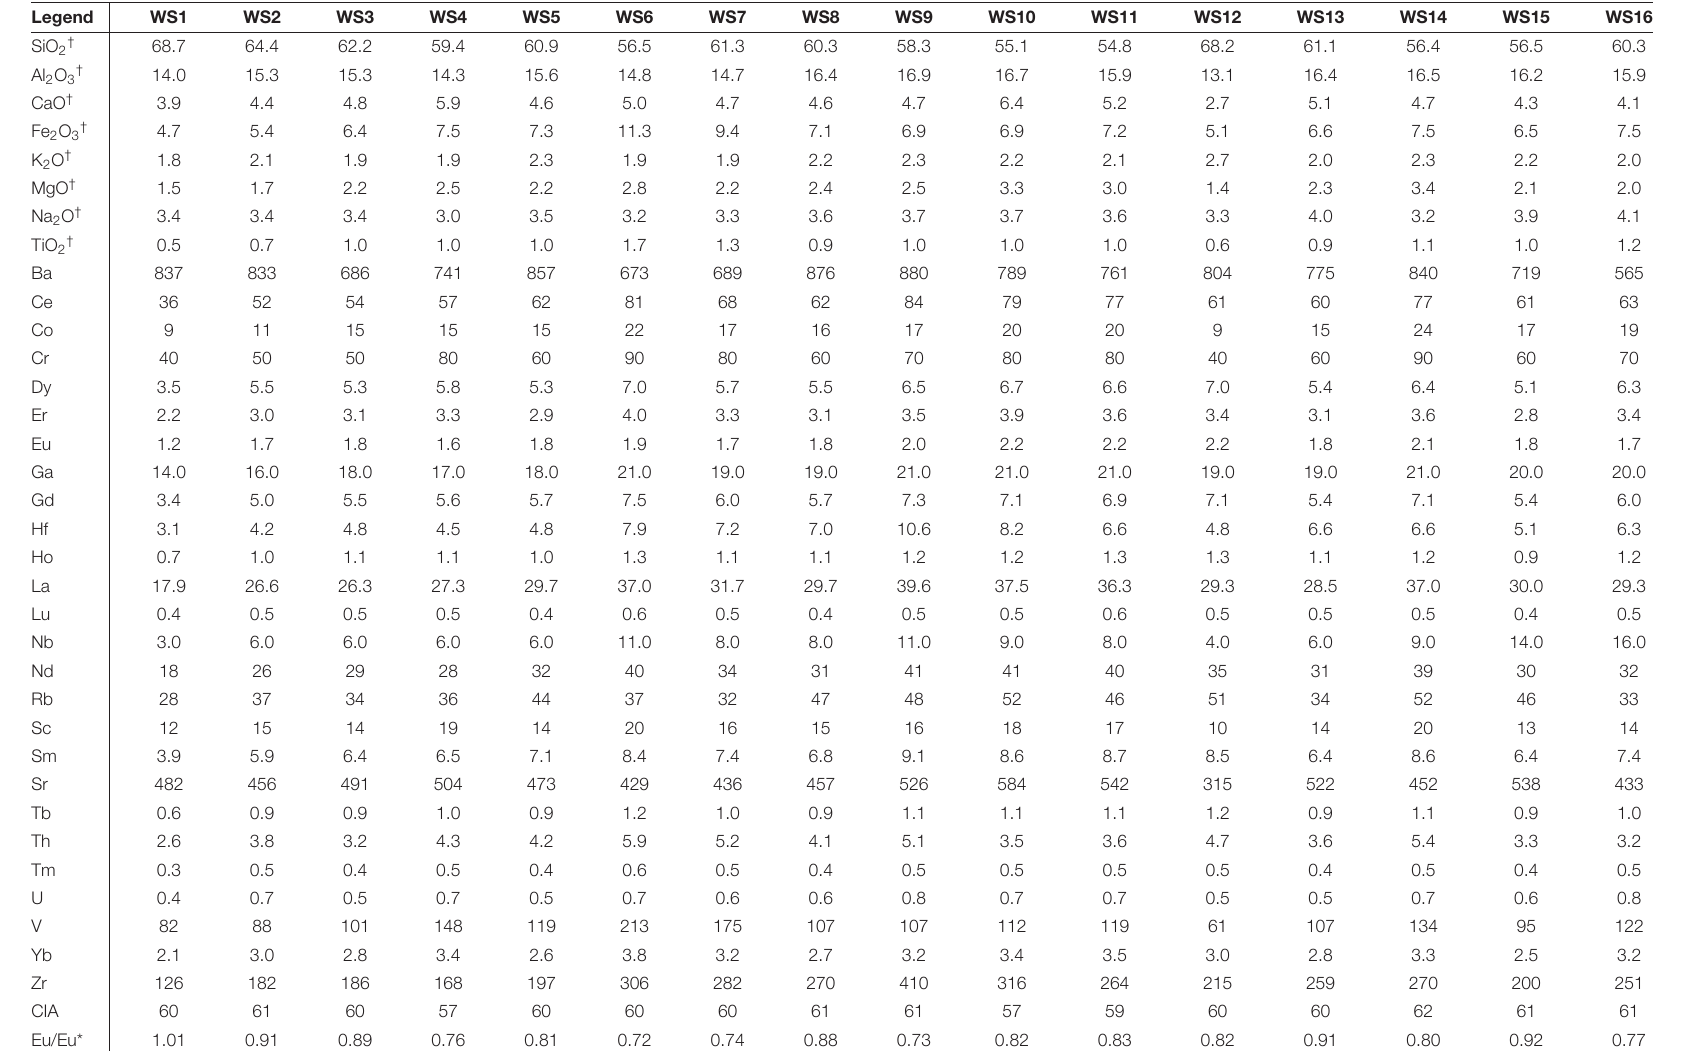
TABLE 1 | Major/minor (wt. %) and trace (including rare earth) (ppm) element compositions of modern and down-core Chew Bahir samples.